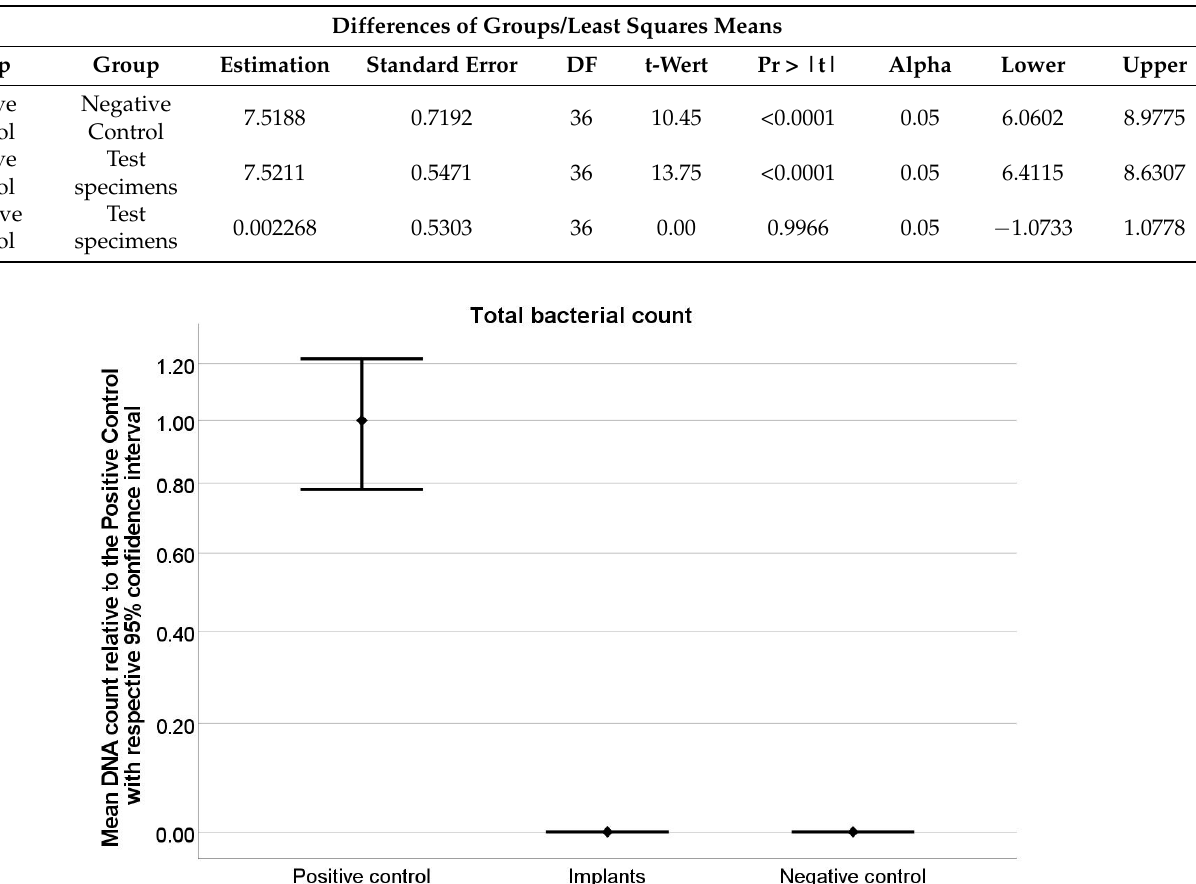
Table 2. Statistical analysis of qrt-PCR amplification results for positive controls ( n = 4—four amplification values per positive control), negative controls ( n = 4—four amplification values per positive control) and implant specimens ( n = 16— two amplification values per implant). Comparison of mean DNA values in mg/mL (Table 1) of the control and test groups demonstrated a significant difference of qrt-PCR results between positive control and test groups ( p < 0.001), whereas no difference was found between the negative control and test groups ( p = 0.99).